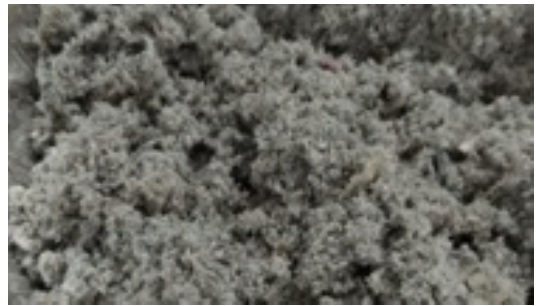
Figure 1. Leather particles used in particleboards.